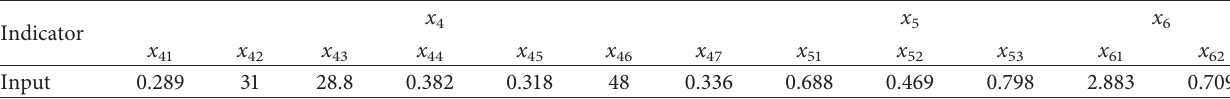
Figure 8: Cloud figures of building vulnerability (Blue for Level I, Green for Level II, Yellow for Level III, Brown for Level IV, Red for Level V, and Black for assessment value). (a) x 11 . (b) x 12 . (c) x 13 . (d) x 14 . (e) x 15 . (f) x 21 . (g) x 22 . (h) x 23 . (i) x 24 (j) x 31 . (k) x 32 . (l) x 33 . Table 6: Assessment inputs of environmental vulnerability indicators.